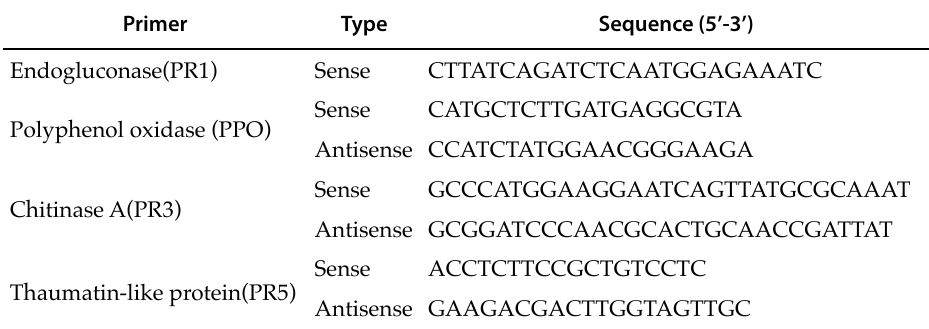
Table 2. Primers used in the molecular